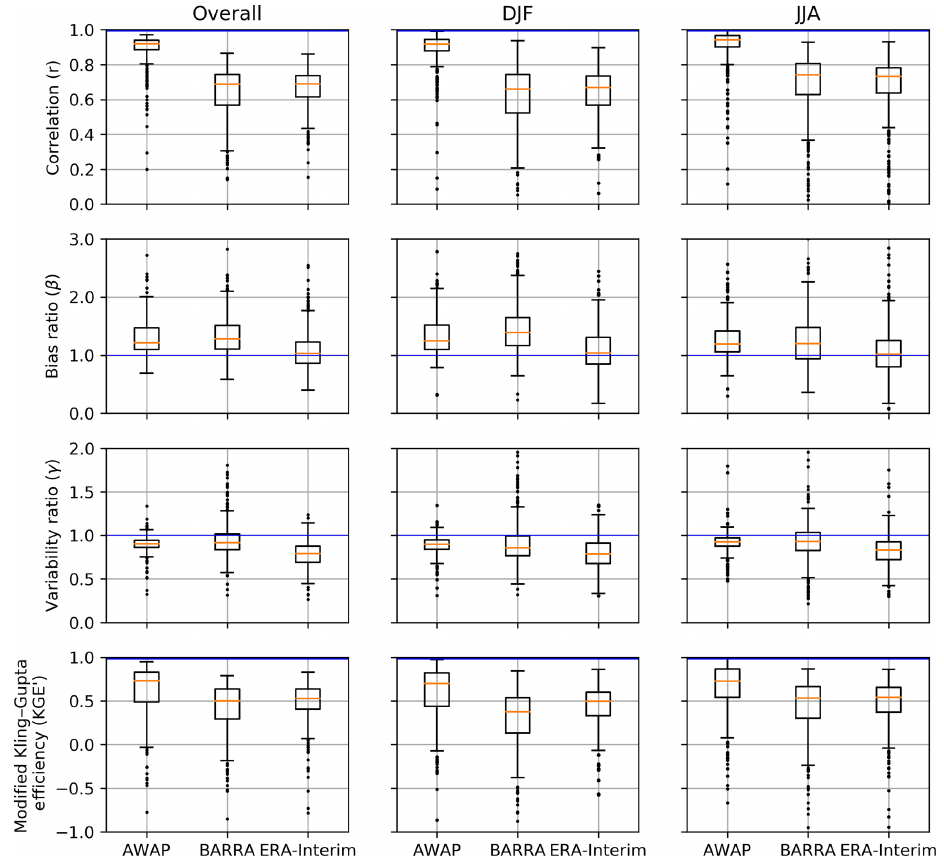
Figure 3. Boxplot of correlation ( r ), bias ratio ( β ), variability ratio ( γ ), and modified Kling–Gupta efficiency (KGE (cid:48) ) between daily pre- cipitation estimates from gridded datasets and observations at gauge locations. Columns represent overall data, summer (DJF), and winter (JJA). Each box extends from first to third quartile, medians are marked in each box, and whisker extends to furthest point or 1.5 times the interquartile range, whichever is closer. The blue horizontal line represents the best